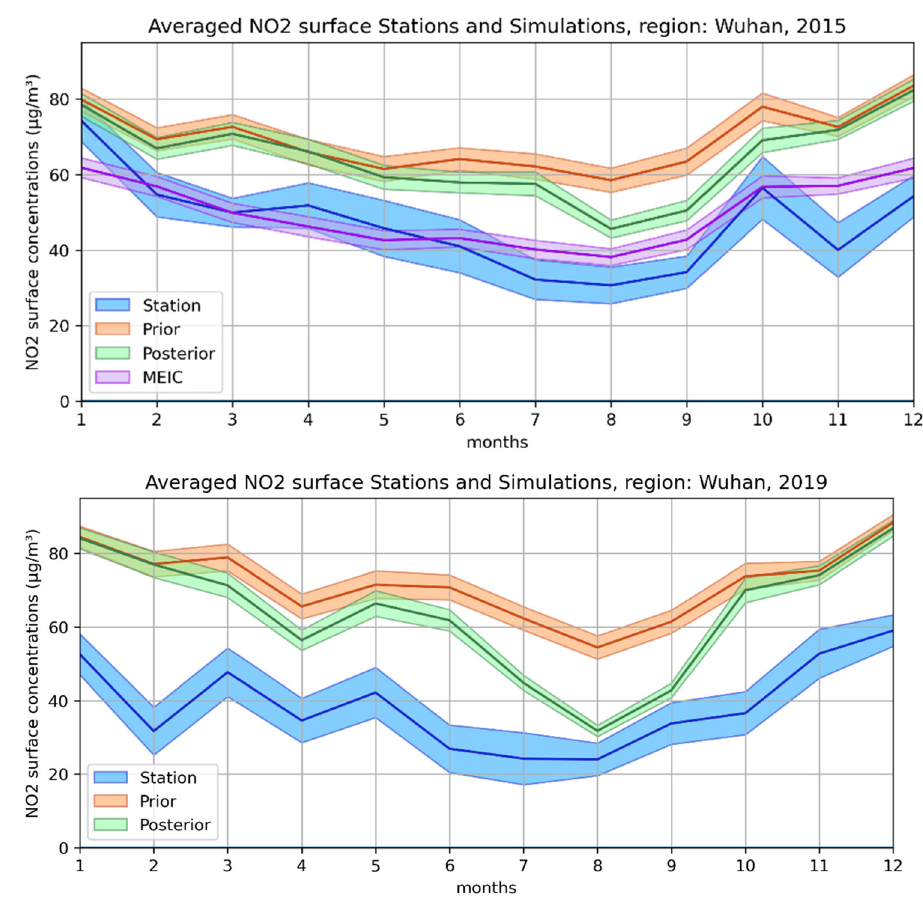
Figure 5. Monthly averaged NO 2 surface concentrations from stations and simulations for Wuhan in ( top ) 2015 and, ( bottom ) 2019.